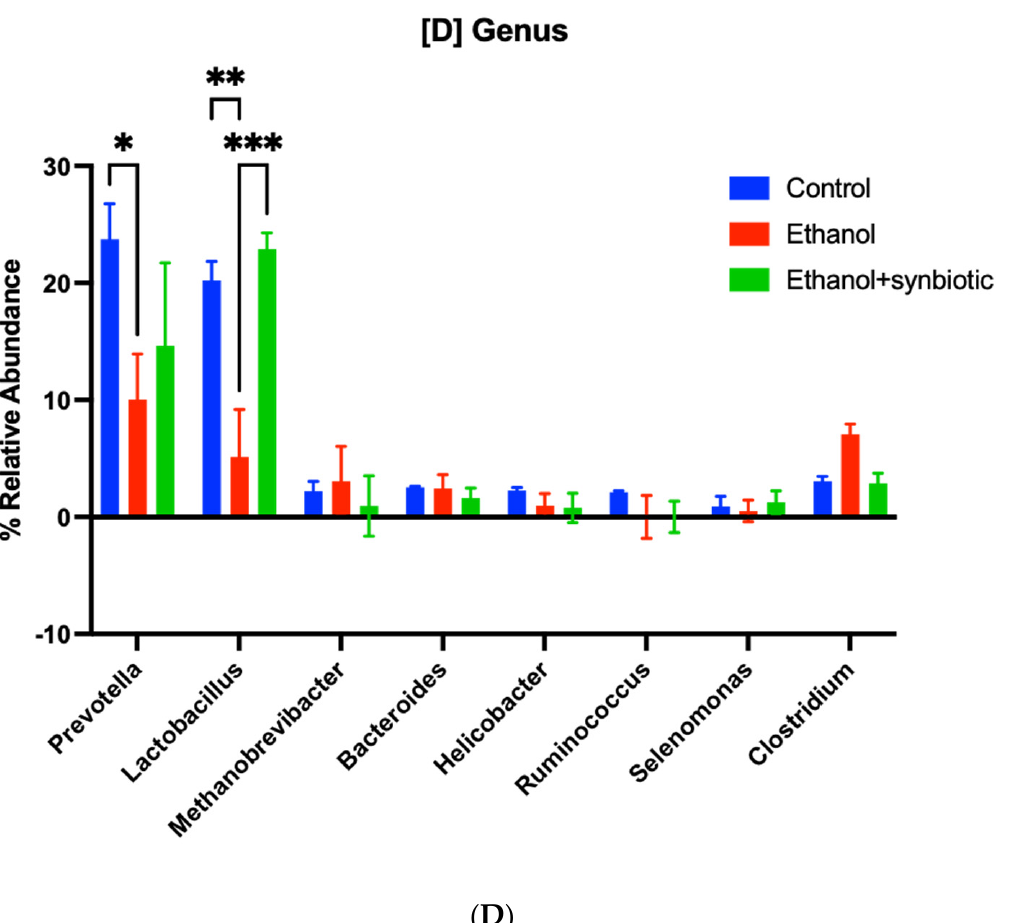
Figure 13. The microbiome of the acute alcoholic male rat model using control, ethanol, and ethanol- and-synbiotic (ES). Taxonomic profiles. Comparative representation of ( A ) Alpha Diversity: Red: Control; Green: Ethanol-and-synbiotic; Purple: Ethanol and ( B ) Beta Diversity, ( C ) phylum level, ( D ) genus level of selected genera among the groups, normalized by the control group. Applying a two-way ANOVA multiple comparison test between the mean of N = 3 to each group, significance is defined as a p -value < 0.05, * p < 0.05, ** p < 0.01, *** p < 0.001.